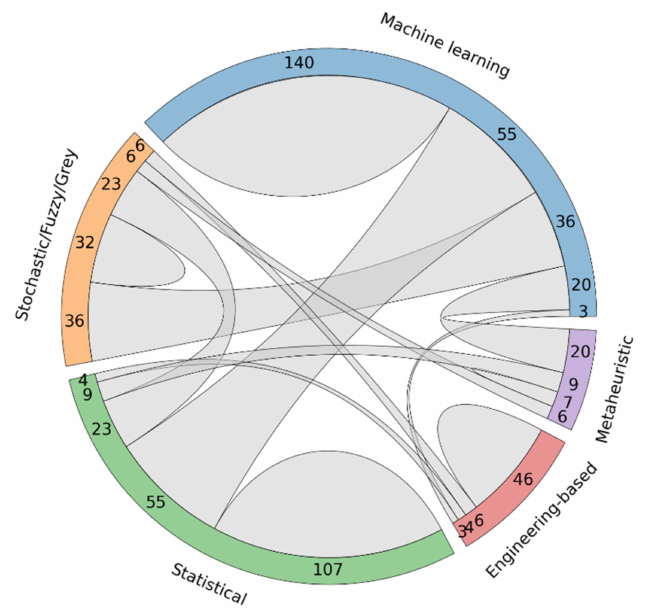
Figure 5. Combination of techniques. An arc connects two categories whenever in an article a combination of techniques from the two categories was used. Self-arcs indicate that a technique was used as a stand-alone approach or was combined with a technique from the same category. The size of the self-arc/arc at its start and endpoint represents the share of stand-alone/combined techniques relative to the total number of